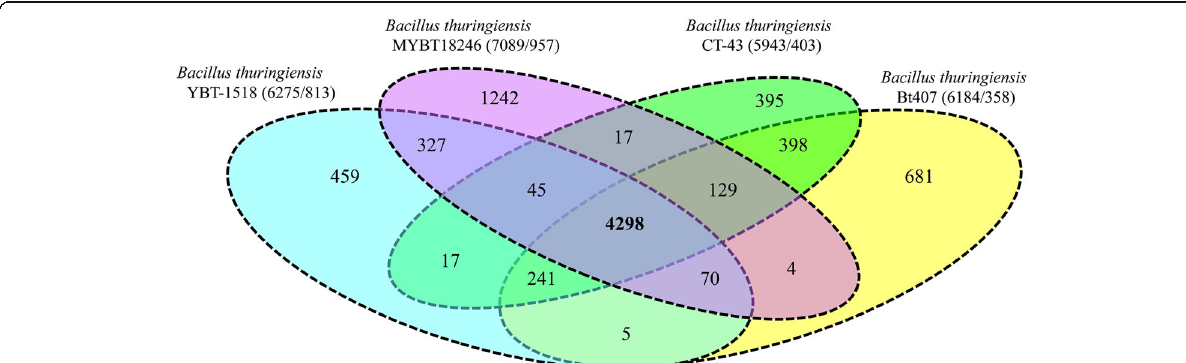
Fig. 4 Venn diagram of the genome comparison of B. thuringiensis MYBT18246 with other B. thuringiensis strains. Venn diagram displays the orthologous genes between B. thuringiensis MYBT18246 (CP015350-CP015361), B. thuringiensis YBT-1518 (CP005935-CP002486), B. thuringiensis serovar chinensis CT-43 (CP001907-CP001917) and B. thuringiensis Bt407 (CP003889-CP003898). Ortholog detection was performed with Proteinortho [84] including protein blast with a similarity cut-off of (50%) and an E-value of 1e − 10 . The total number of genes and paralogs are depicted under the corresponding species name. Open reading frames that were classified as pseudogenes were not included in this analysis